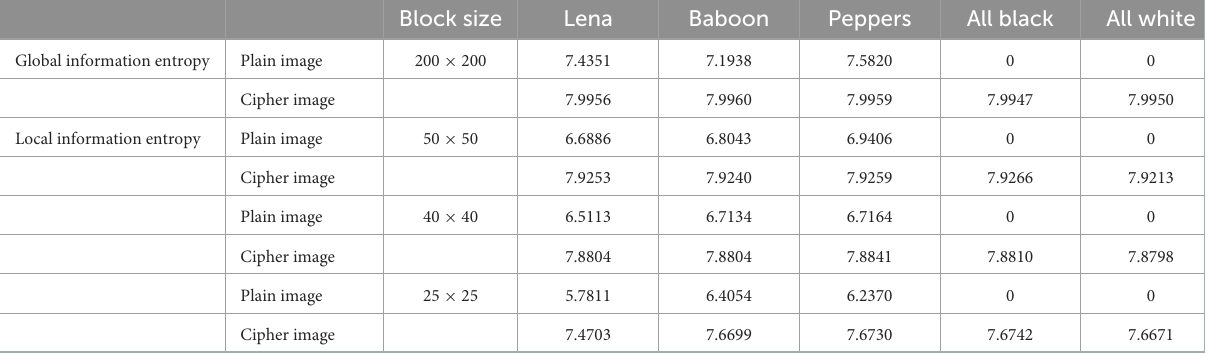
2D correlation between plain and cipher image TABLE 11 Global and local information entropy. Block size Lena Baboon Peppers All black All